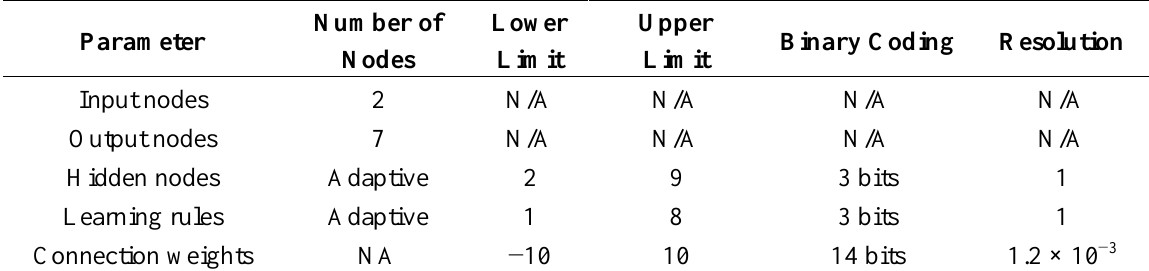
Table 4. NN parameters.